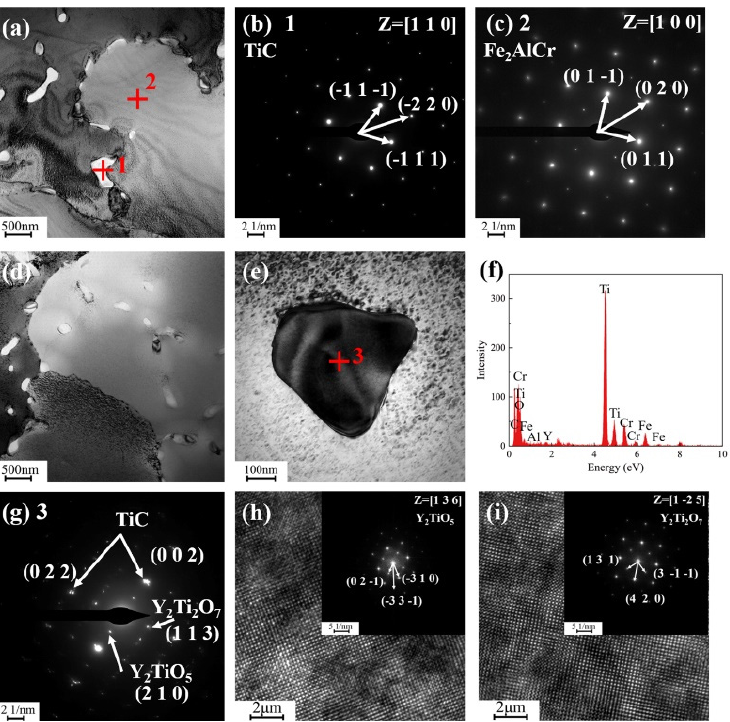
Figure 6. TEM results of coatings ( a ) microstructure of 0 wt.% Y 2 O 3 coating, SAD of ( b ) point 1, ( c ) point 2; 0.2 wt.% Y 2 O 3 , ( d ) microstructure of 0.2 wt.% Y 2 O 3 coating, ( e ) TEM image of precipitated TiC, ( f ) EDS of point 3, ( g ) SAD of point 3; HRTEM and FFT patterns of ( h ) Y 2 TiO 5 ( i ) Y 2 Ti 2 O 7 .